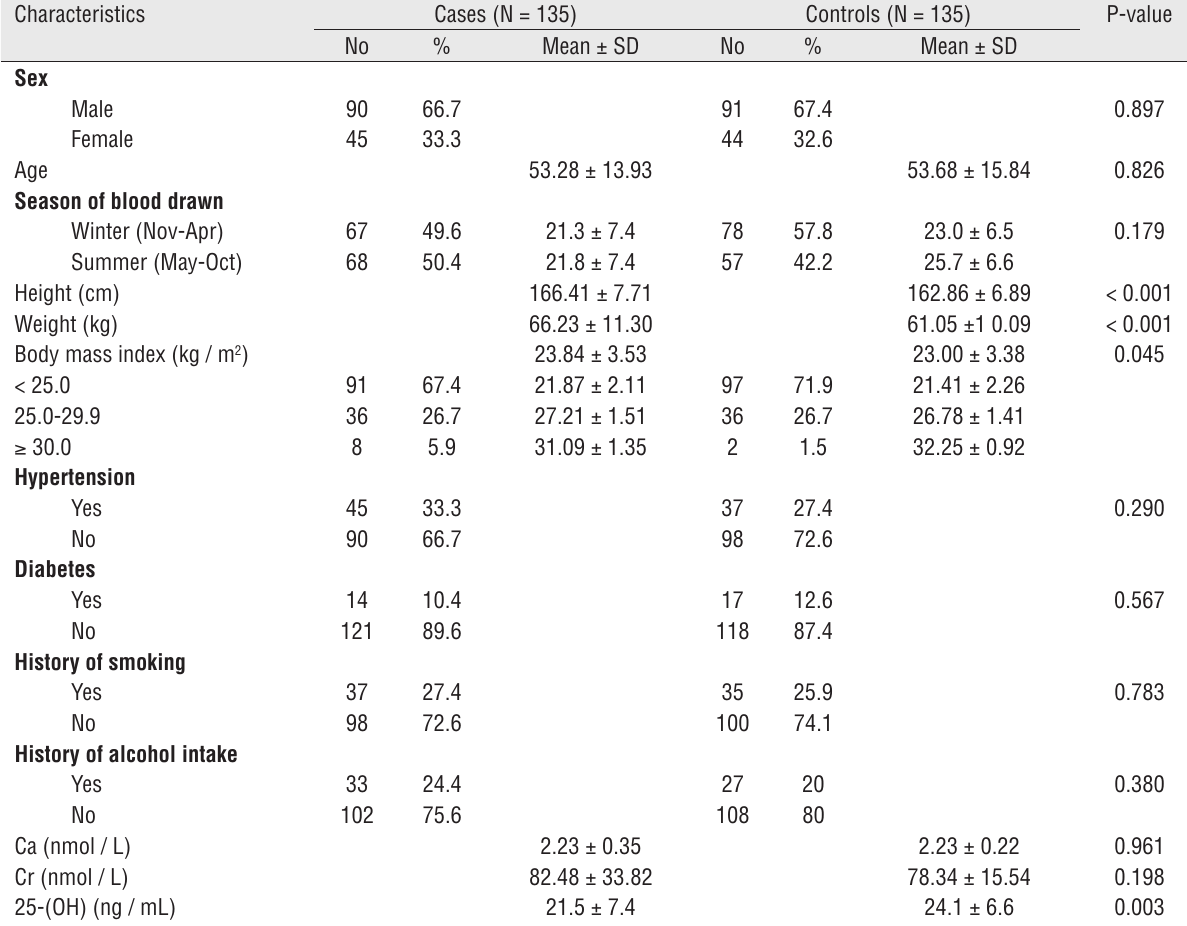
Table 1 - Baseline characteristics of cases and controls.